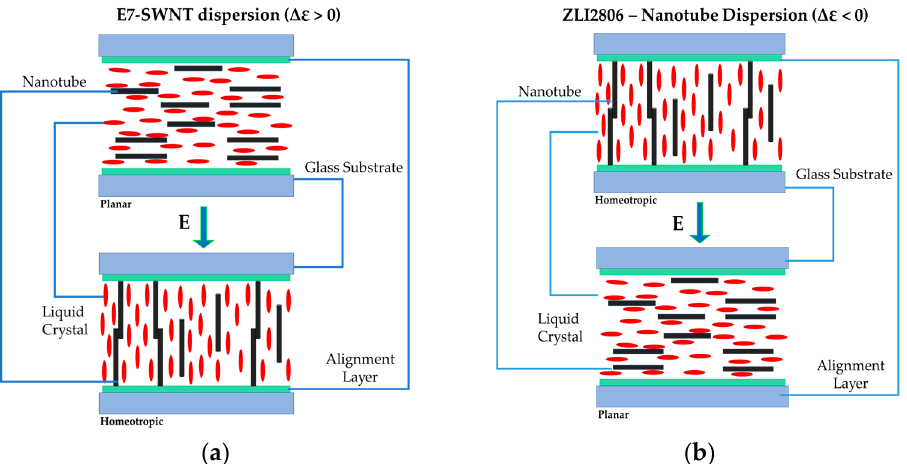
Figure 7. The electric-field-induced reorientation processes of CNTs in LC-CNT composites: ( a ) From a planar to homeotropic transition for a dielectrically positive LC-CNT dispersion and ( b ) from a homeotropic to planar transition for a dielectrically negative LC-CNT dispersion.